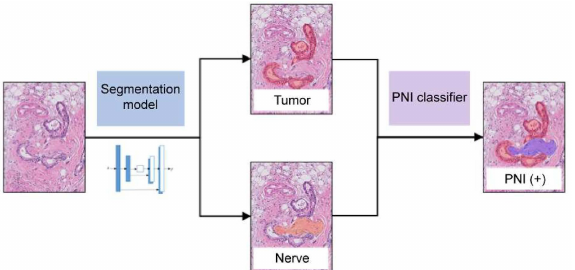
Figure 1. Proposed pipeline for PNI detection. The framework consists of a segmentation network and a PNI classifier. Tumor (red) and nerve masks (orange) were extracted according to the segmentation model. The extracted nerve areas were classified as PNI when they were close to the